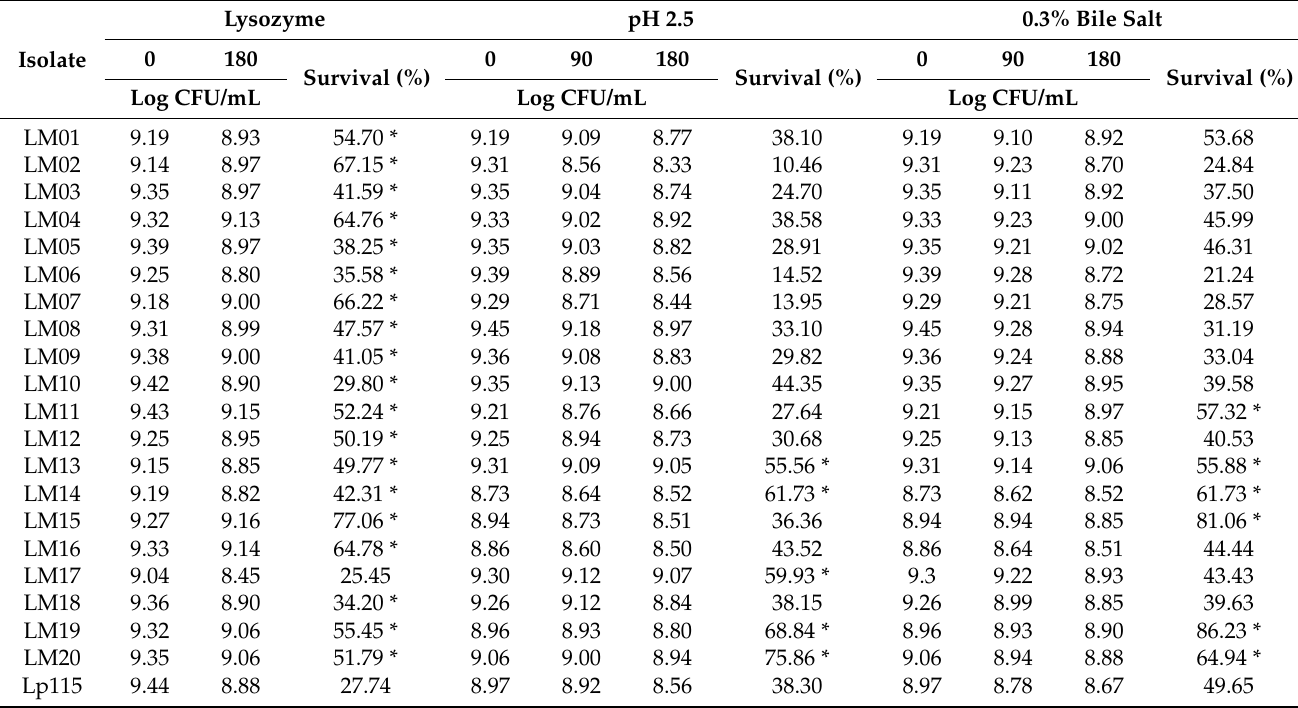
Table 2. Tolerance to gastrointestinal tract conditions of lactic acid bacteria (LAB) isolated from agave fermentation: 0, 90, and 180 min of incubation.